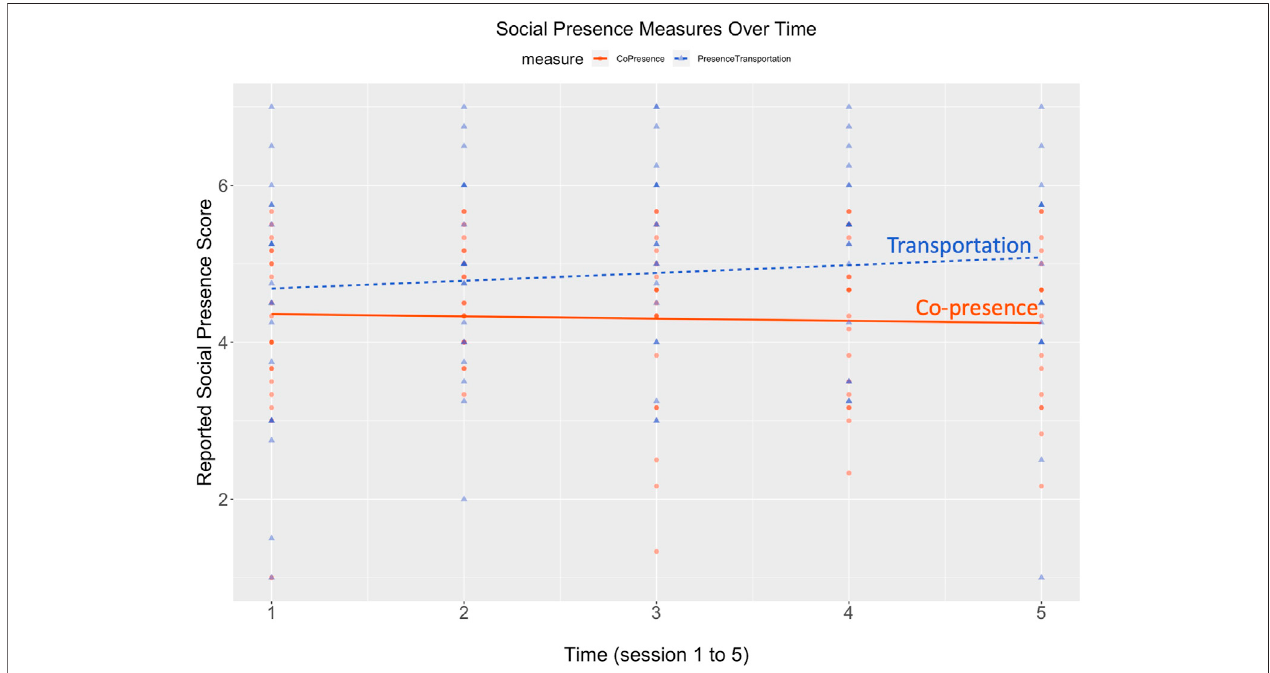
FIGURE 12 | Ratings of social presence Co-presence and Transportation over